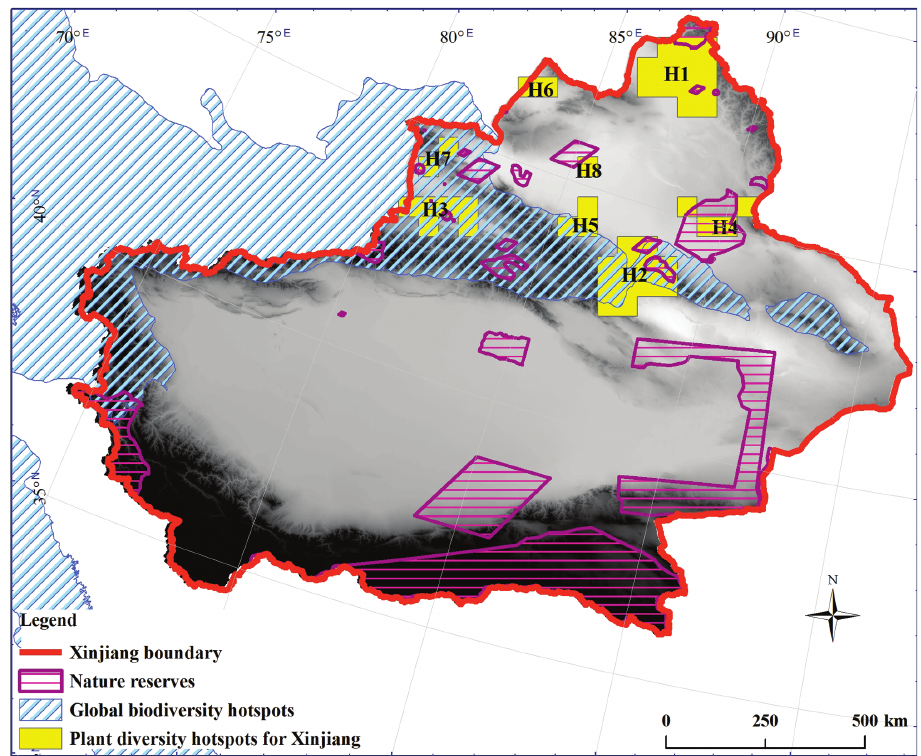
Figure 4. Geographic distributions of seed plant conservation and priority conservation gaps in Xinjiang, northwest China. Albers projection. Hotspot centre codes are consistent with those listed in Table